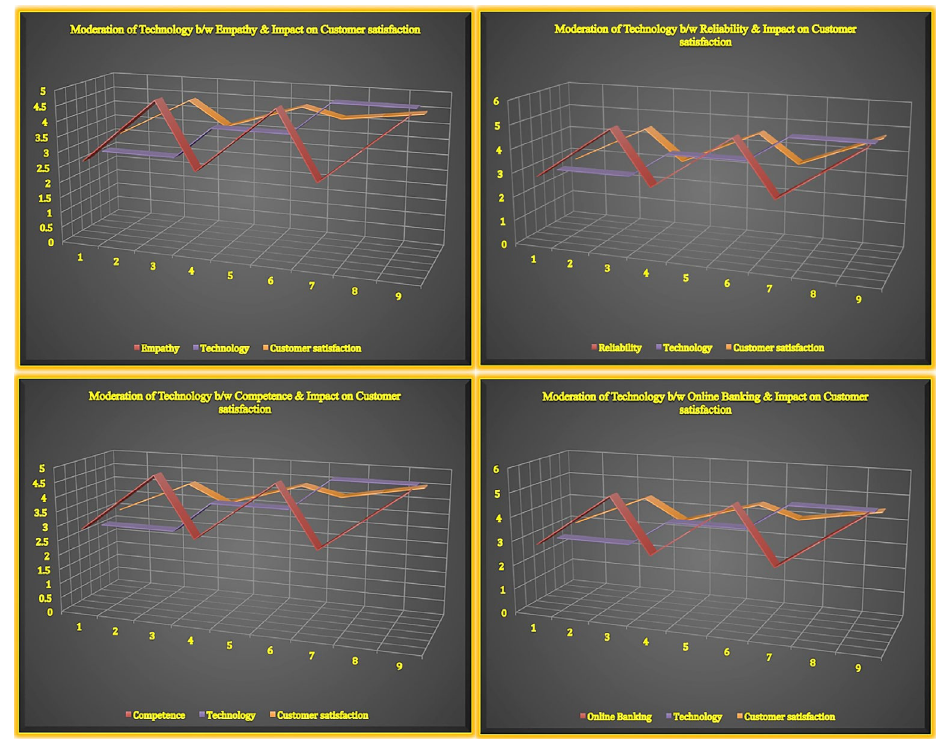
Fig. 2. 3D plots of the interaction of service quality dimensions with technology and visualizing conditional impact on customer